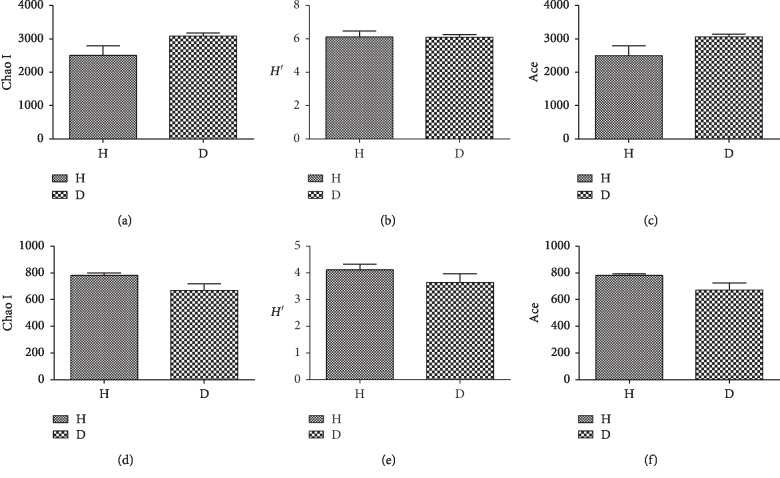
Bacterial and fungal diversity in the rhizosphere of healthy and rusty root-affected Panax ginseng. (a), (b), and (c) show the Chao I H′, and Ace index values, respectively, for the bacterial community. (d), (e), and (f) show the Chao I H′, and Ace index values, respectively, for the fungal community. All values are presented as means ± SE (n = 3). H: healthy plants; D: diseased plants.